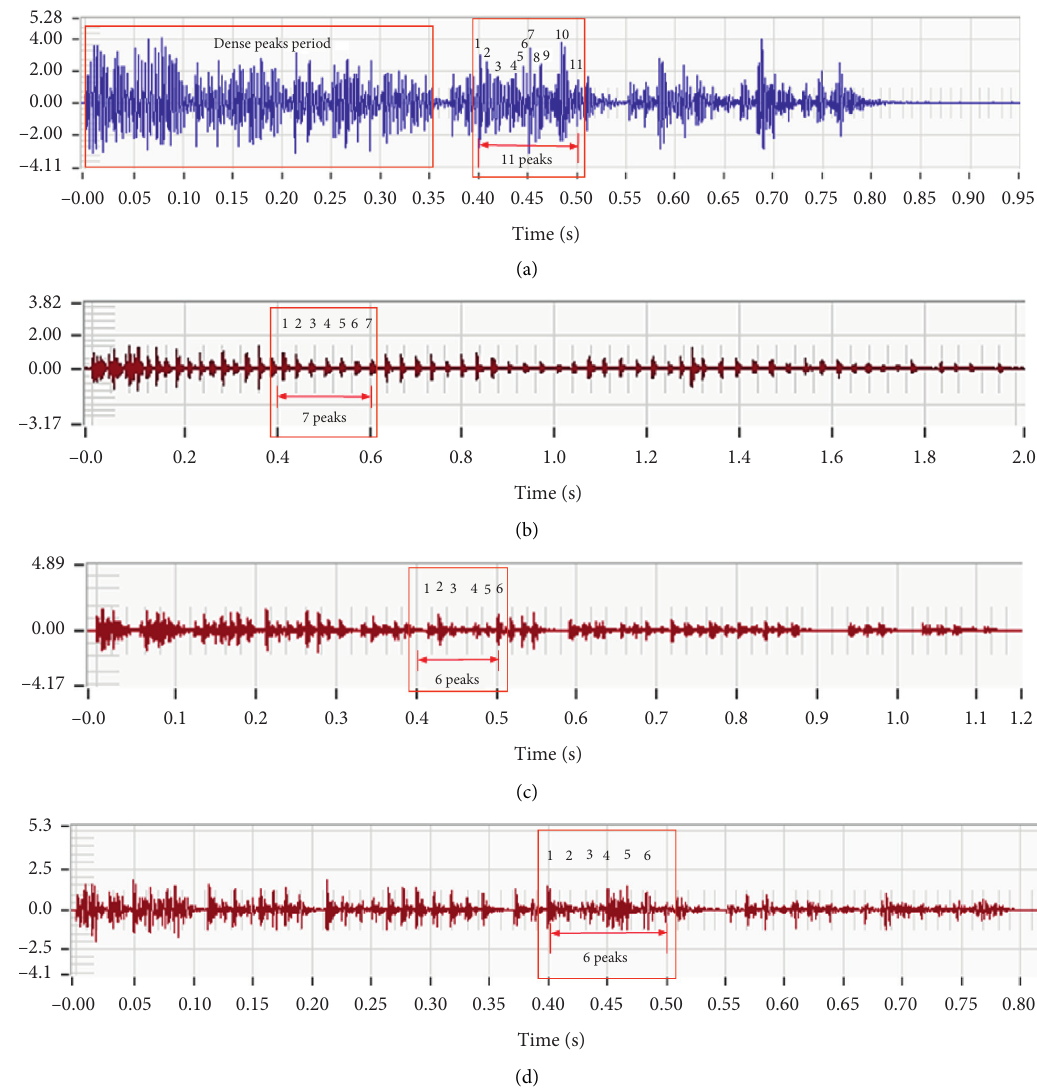
Figure 11: Vertical vibration velocity curves of blasting tests: (a) point A, (b) point B, (c) point C, and (d) point